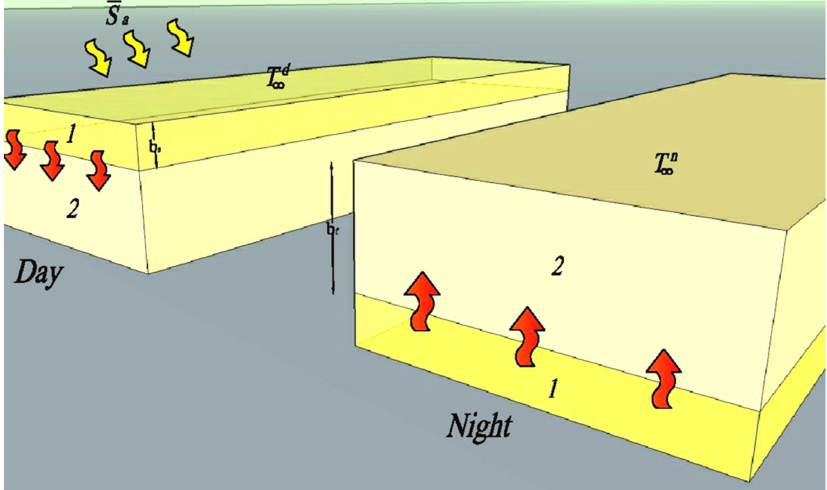
Figure 3. Diagram for determining the boundary of liquid and solid phase PCM; 1-liquid phase; 2-solid phase, according to the concept [2].